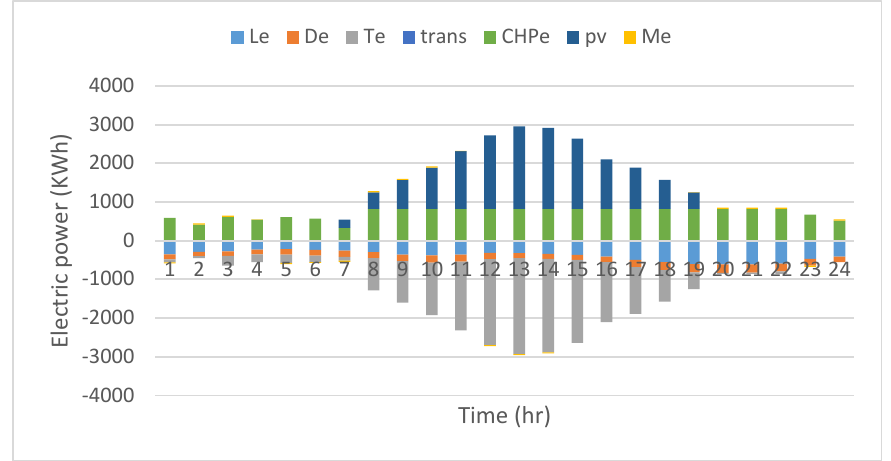
Figure 14. Equivalent storage heat flows and the SOC of thermal storage in a winter off-day for the last year.